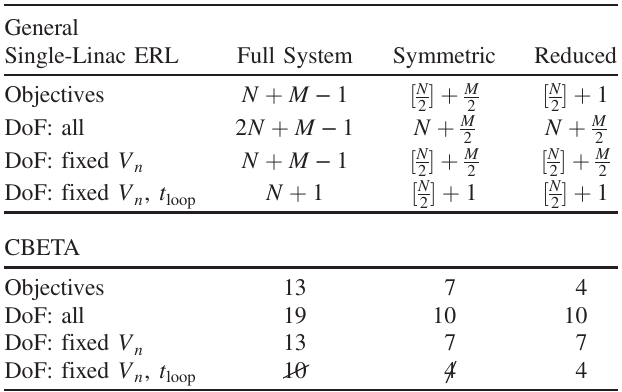
TABLE I. Objectives and degrees of freedom (d.o.f.) for: a fully independent ERL, one with symmetric operation, and a reduced symmetric system where only the highest loop energy, E , is loop ; M 2 used as an objective function. Also shown are decreased numbers of d.o.f. when only voltage ( V n ), or both voltage and intermediate loop flight times ( t ), are set at constant values. Crossed out loop ;m ≠ M 2 options are unhelpful for